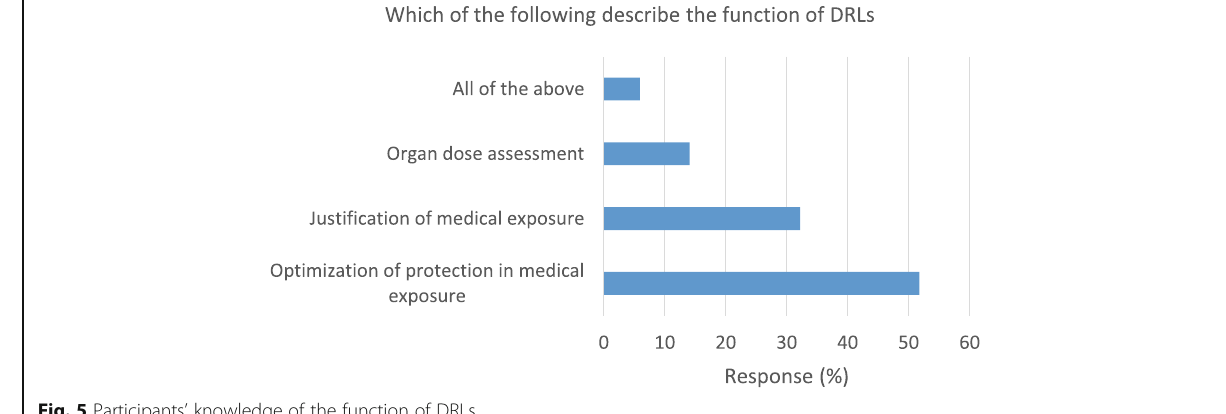
Fig. 5 Participants ’ knowledge of the function of DRLs